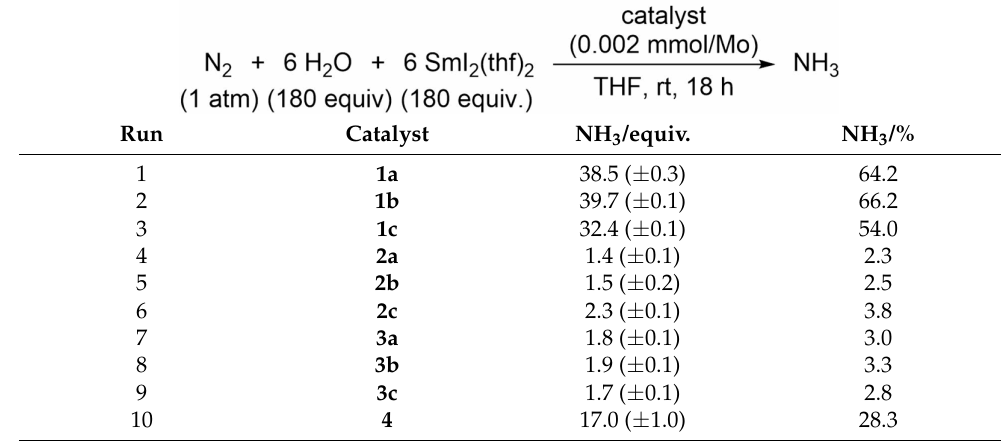
Table 1. Results of catalysis with the PN 3 P-Mo(III) halide complexes with 180 equiv. SmI 2 /H 2 O.